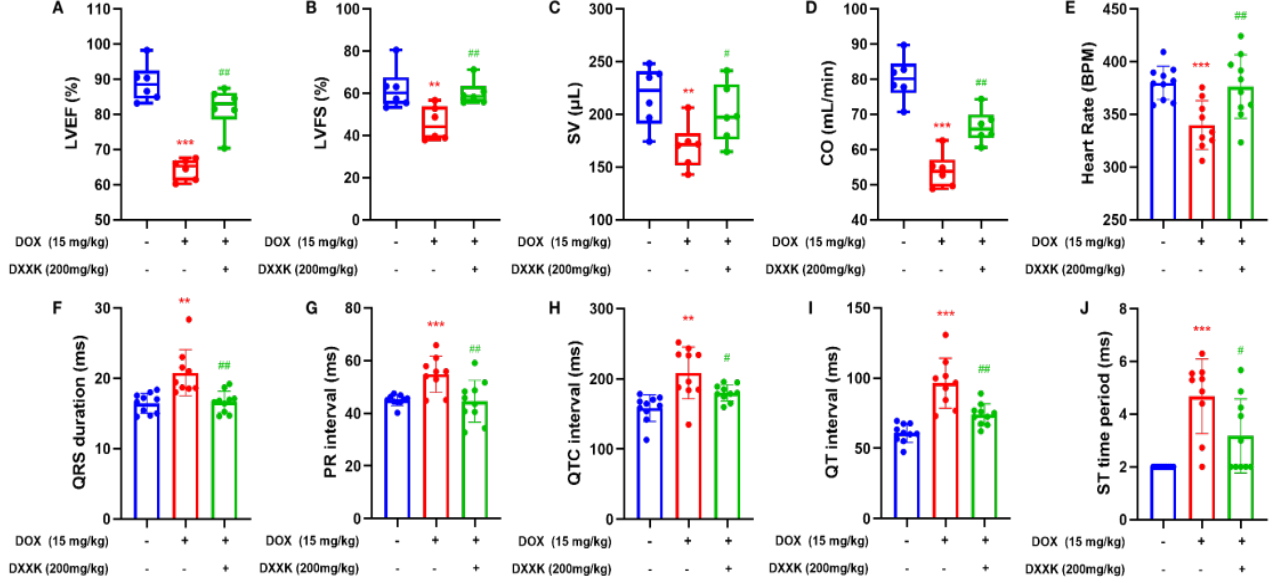
Figure 2. DXXK can improve DOX-induced cardiac function decline and electrical signal conduction block in rats. ( A ) LVEF; ( B ) LVFS; ( C ) CO; ( D ) HR; ( E ) QRS duration; ( F ) PR interval; ( G ) QTC inter- val; ( H ) QT interval; (I) QT interval; ( J ) ST time period. ** p < 0.01 and *** p < 0.001 compared with the control group. # p < 0.05 and ## p <0.01 compared with the DOX group. ” + ” indicates that drugs are added, and “ - ” indicates that drugs are not added.